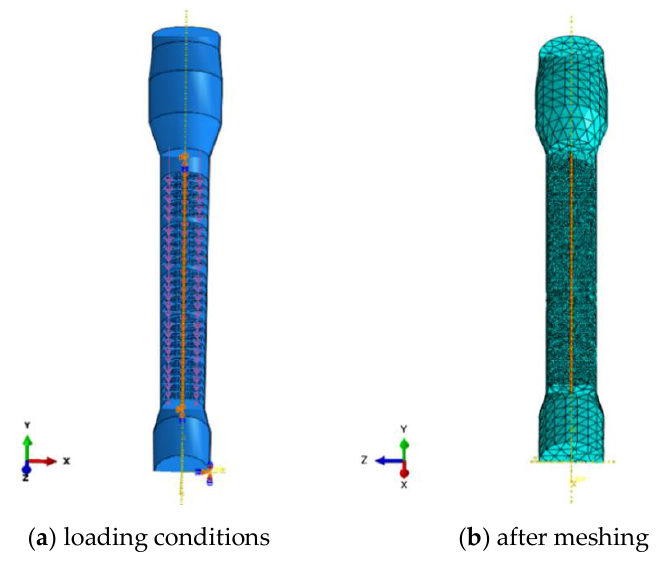
Figure 9. The finite element model of the extraction column. Table 1. Physical and mechanical properties of 316 stainless steel.